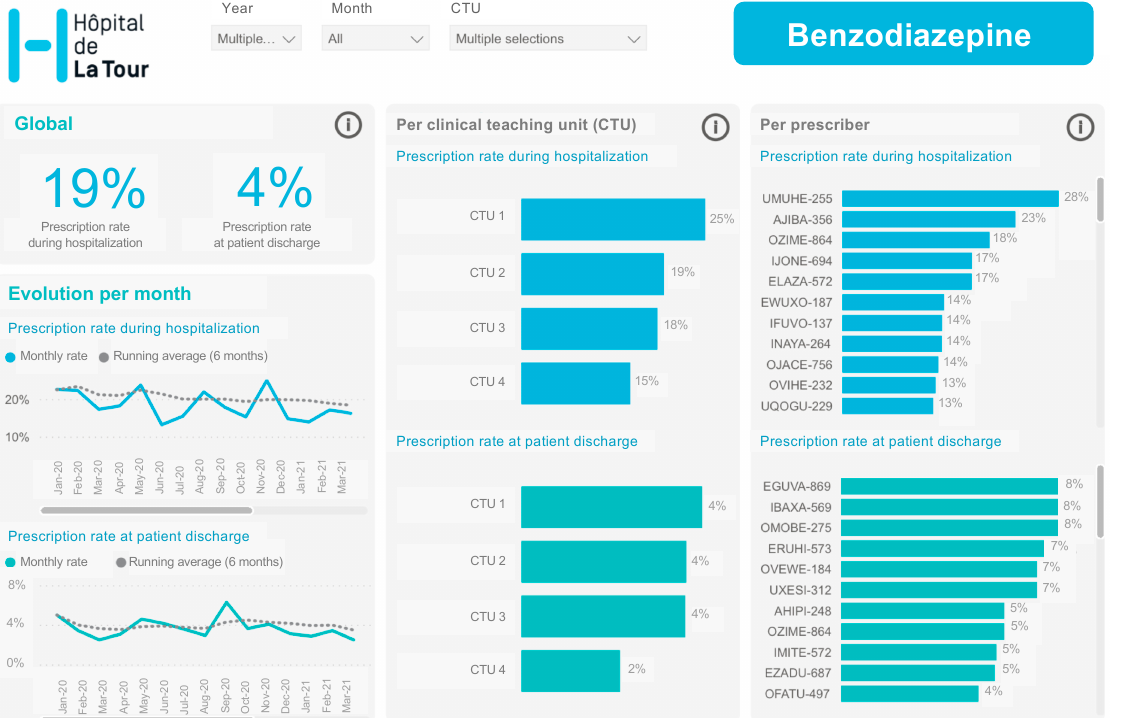
Figure 1. Dynamic dashboard based on prescription data.